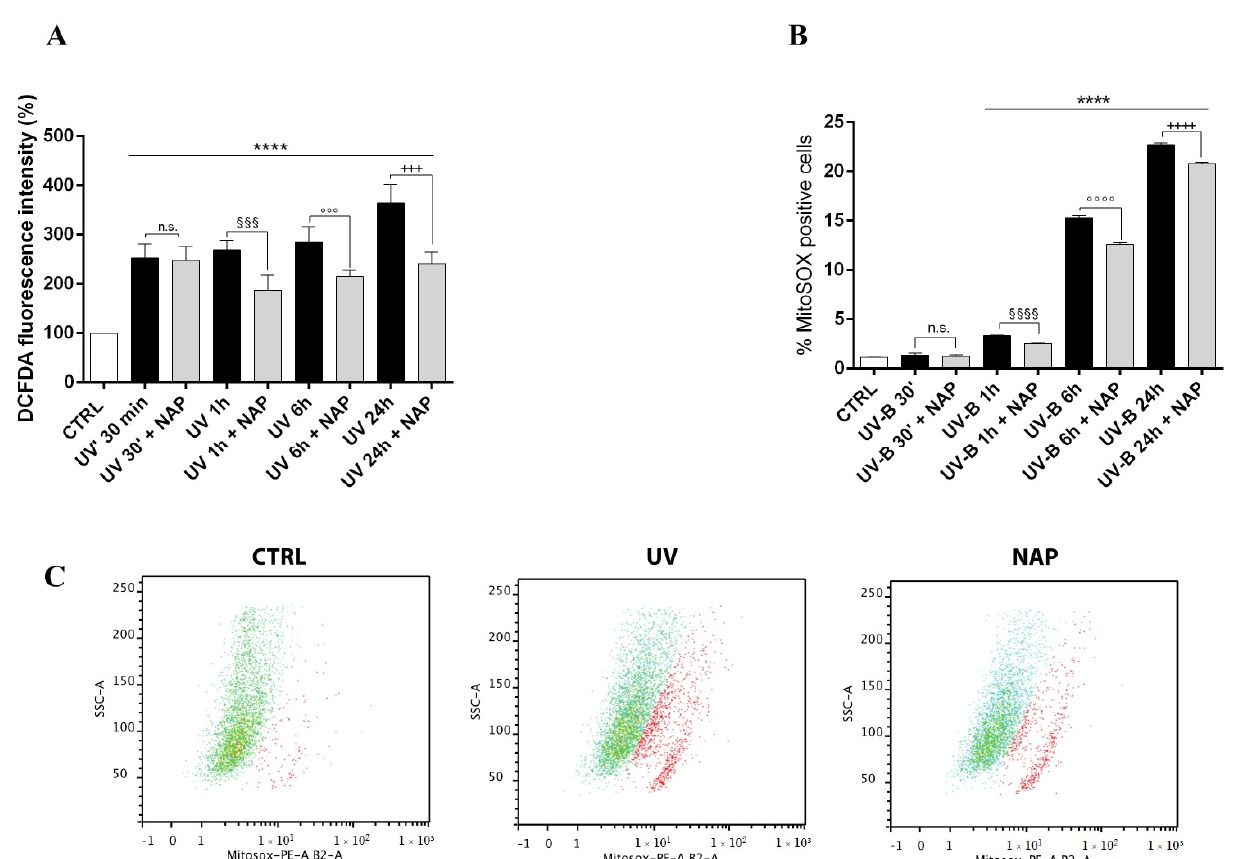
Figure 6. Effect of NAP on UV-B-induced ROS production on corneal epithelial cells. Intracellular ROS levels were measured in SIRC cells at different time intervals after UV-B irradiation using the cytoplasmic probe, DCFDA ( A ), or the mitochondrial probe, MitoSOX™ Red ( B ) at different time points after irradiation with or without NAP treatment. ( C ) Representative flow cytometry analysis of mitosox Red staining at 6 h. Data are expressed as mean ± SEM of three independent experiments and values are expressed as % of MitoSOX™ Red positive cells. **** p < 0.0001 vs. CTRL; §§§ p < 0.001 and §§§§ p < 0.0001 vs. UV 1 h; ◦◦◦ p < 0.001 and ◦◦◦◦ p < 0.0001 vs. UV 6 h; +++ p < 0.001 and ++++ p < 0.0001 vs. UV 24 h as determined by one-way ANOVA followed by Tukey’s multiple comparison test.